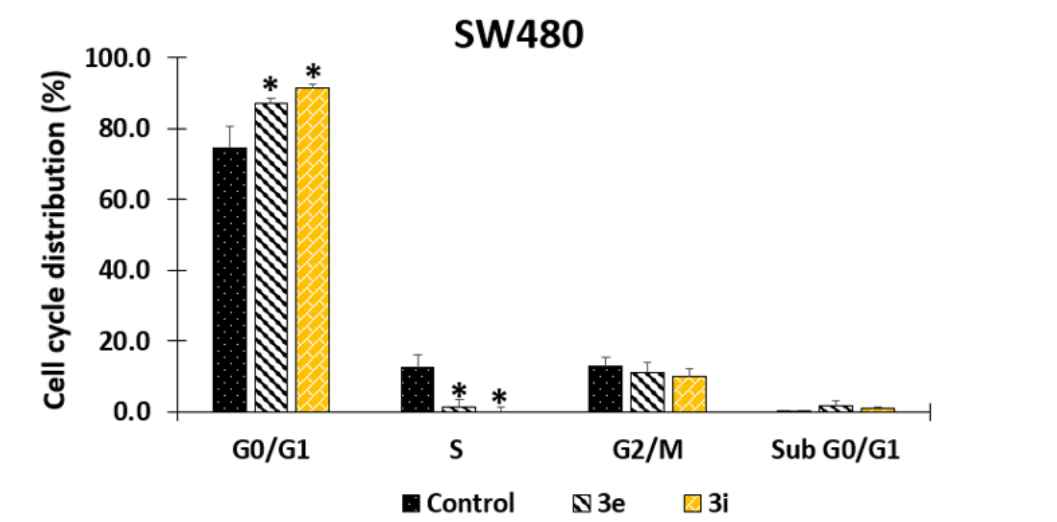
Figure 3 . Cell cycle analysis of SW480 cells after treatment with DMSO (1%) or the hybrids based on curcumin/resveratrol. After 48 h of treatment, cells were labeled with PI and analyzed by DNA flow cytometry. The data indicate the percentage of cells in each phase of the cell cycle. All experiments were performed in duplicate and gave similar results. p values lower than 0.05 were considered statistically significant (* p < 0.05).